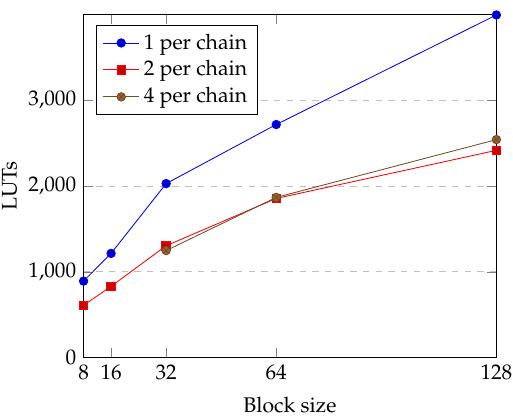
Figure 17. LUT use in packer module for various B and N per _ chain , N p = 4.